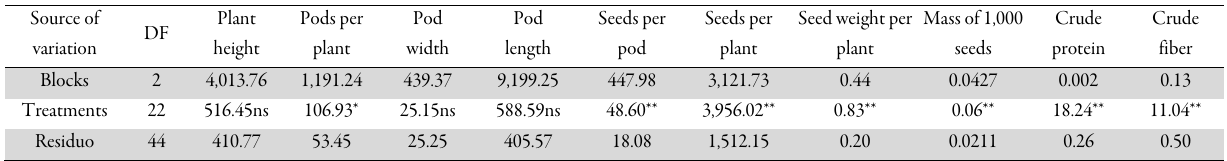
Table 1. Dispersion analysis (ANOVA) for the studied traits in white lupine cultivars Source of Plant DF variation